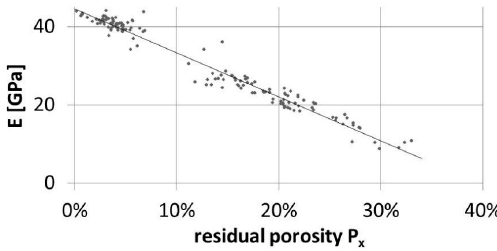
Figure 3. Relationship between Young’s modulus E of sintered MIM Mg-0.9Ca parts and corresponding residual porosity P x .